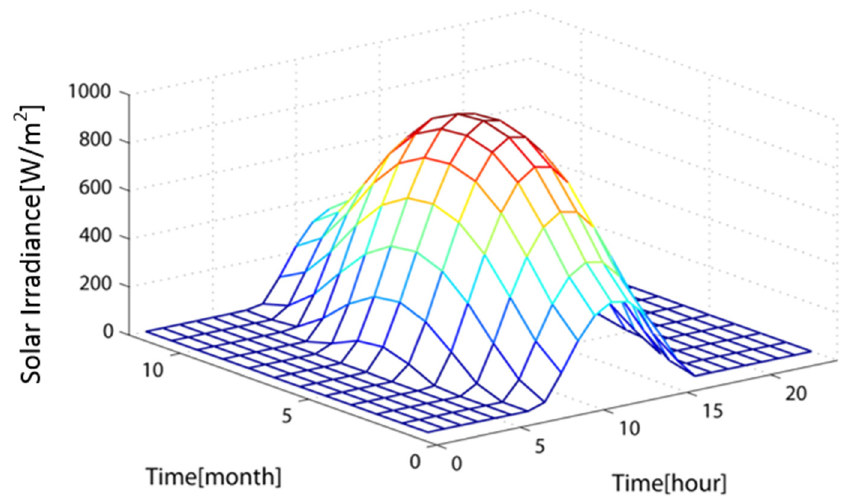
Figure A1. Theoretical solar irradiance.